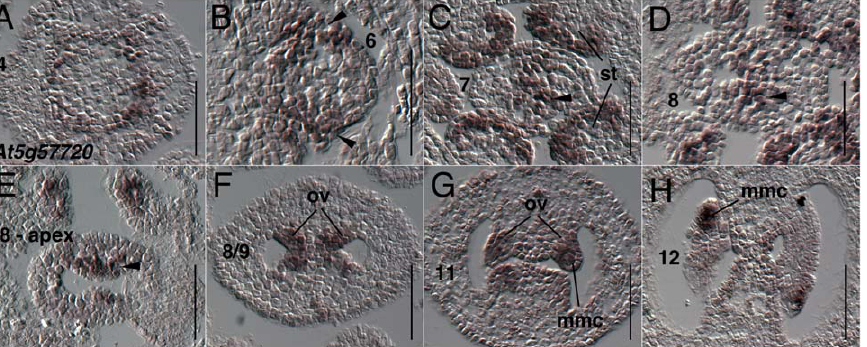
Figure 7. Results of insitu hybridization with AT5G57720 ( REM15 ) antisense probe. Numbers indicate floral stages. All panels show transverse (cross sectional) tissue orientation. Arrowheads indicate medial domain expression. ov - ovule; st- stamen primordia; mmc - megaspore mother cell. Scale bars in all panels are 50 microns. All panels are Col-0 wild type tissue.